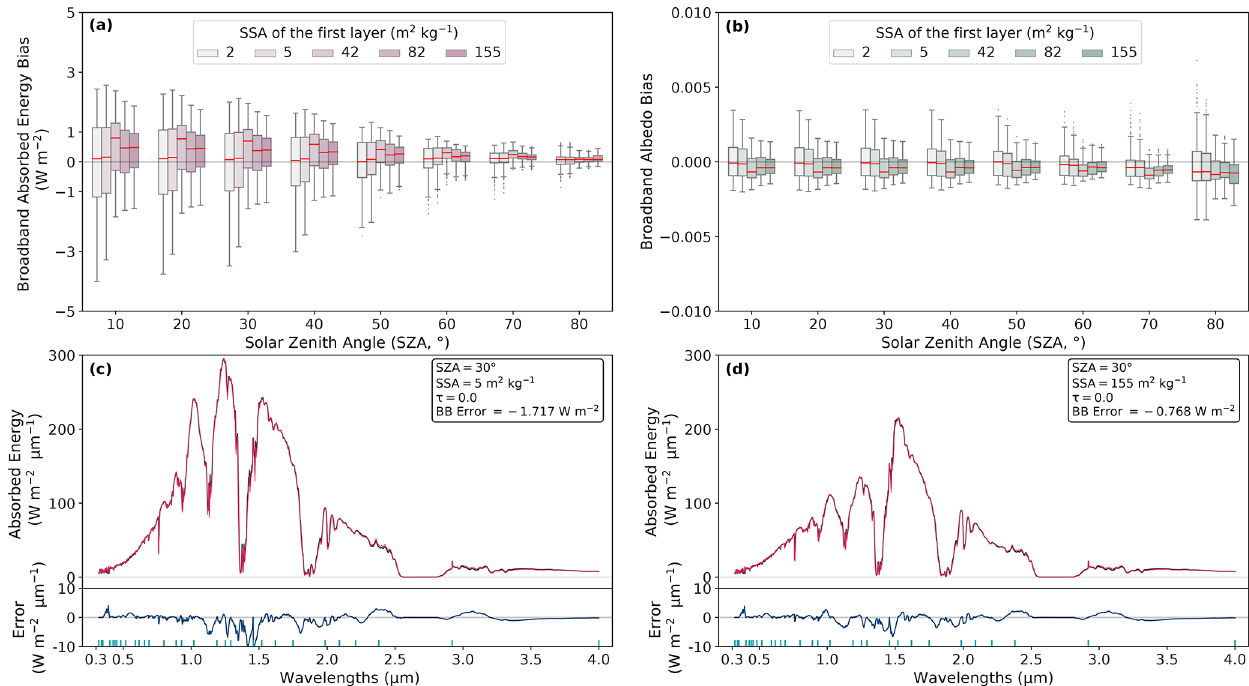
Figure 4. Bias on the broadband absorbed energy (a) and on the broadband albedo (b) as a function of the SZA and the SSA of the first layer (m 2 kg − 1 ). The biases are calculated for all the simulations described in Sect. 2.5.3 and 2.5.4 between the absorbed energy calculated by the method and the reference absorbed energy calculated by the TARTES–SBDART. The red lines indicate the median, the box shows the 25th to 75th percentiles, and the whiskers show the 5th to 95th percentiles. Example of absorbed energy profiles for a snowpack without LAPs as a function of wavelength calculated for an SZA of 30 ◦ and an SSA value of 5m 2 kg − 1 (old snow, c ) as well as an SSA value of 155m 2 kg − 1 (fresh snow, d ). The black lines represent the absorbed energy calculated by TARTES–SBDART at 1nm resolution, and the red lines represent the absorbed energy calculated by VALHALLA. In blue, the errors on the absorbed energy for these same simulations are shown as a function of wavelength. The green vertical lines represent the TPs used in